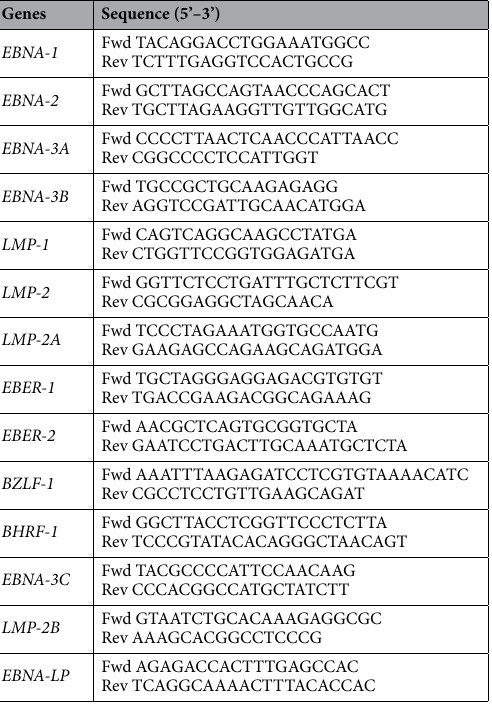
Table 1. EBV latency-associated genes along with sequences of the forward and reverse primers. Fwd forward primer, Rev reverse